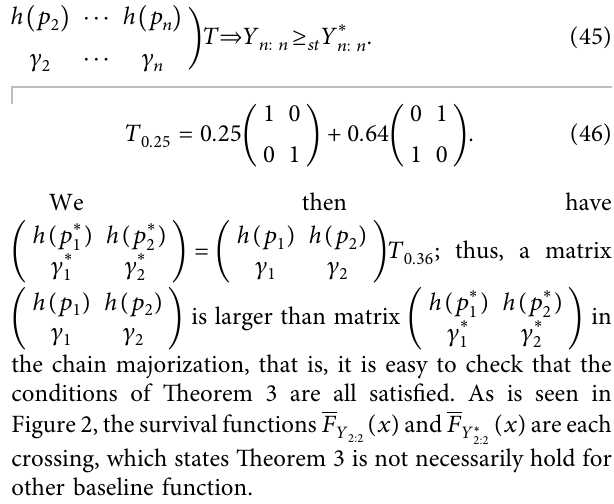
Figure 2, the survival functions F Y crossing, which states Theorem 3 is not necessarily hold for other baseline